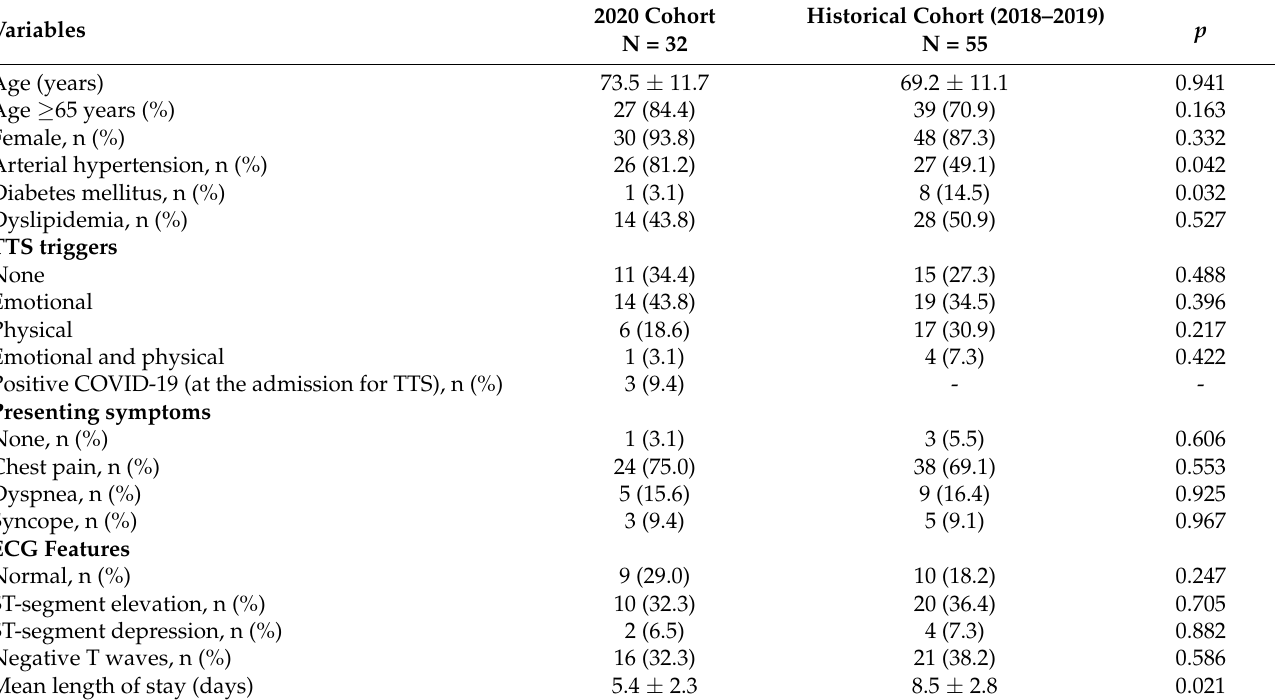
Table 1. Trends in Takotsubo (TTS) event rates also stratified by gender between 2018 and 2020. CI: confidence interval.